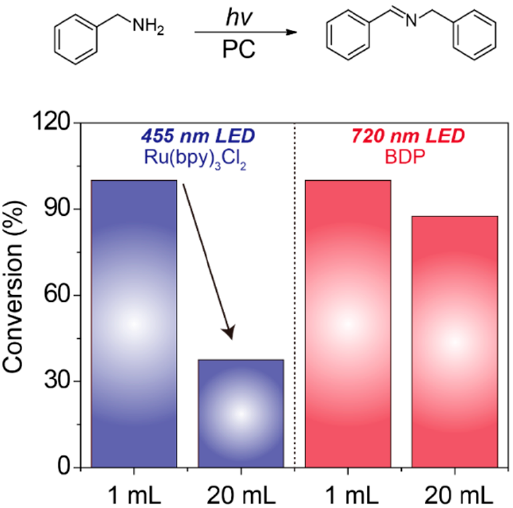
that BDP was an excellent NIR photocatalyst to efficiently promote the oxidative coupling of benzylamine derivatives with broad substrate scope.